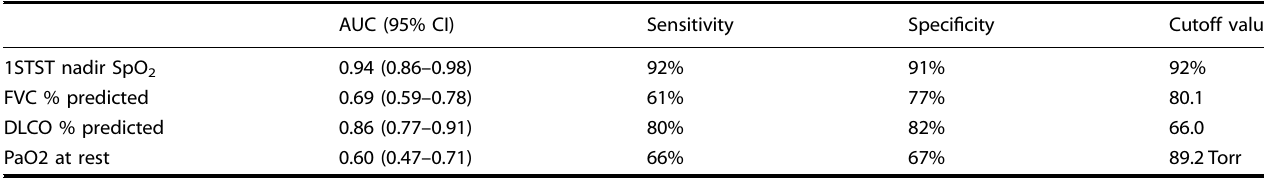
SpO 2 pulse oxygen saturation, PaO2 arterial partial pressure of oxygen, 1STST 1 min sit-to-stand test, 6MWT 6 min walk test, FVC forced vital capacity, DLCO diffusion lung capacity for carbon monoxide, AUC area under the curve, CI con fi dence